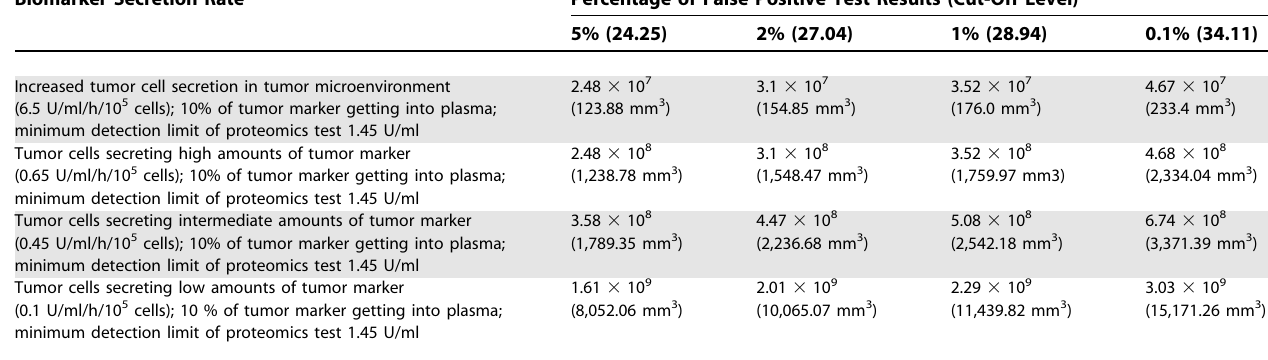
Table 7. Minimum Detectable Tumor Cell Number and Estimated Tumor Size (in mm 3 ) as a Function of CA125 Proteomics Test Assay Cut-Off Level/Specificity of Test Results